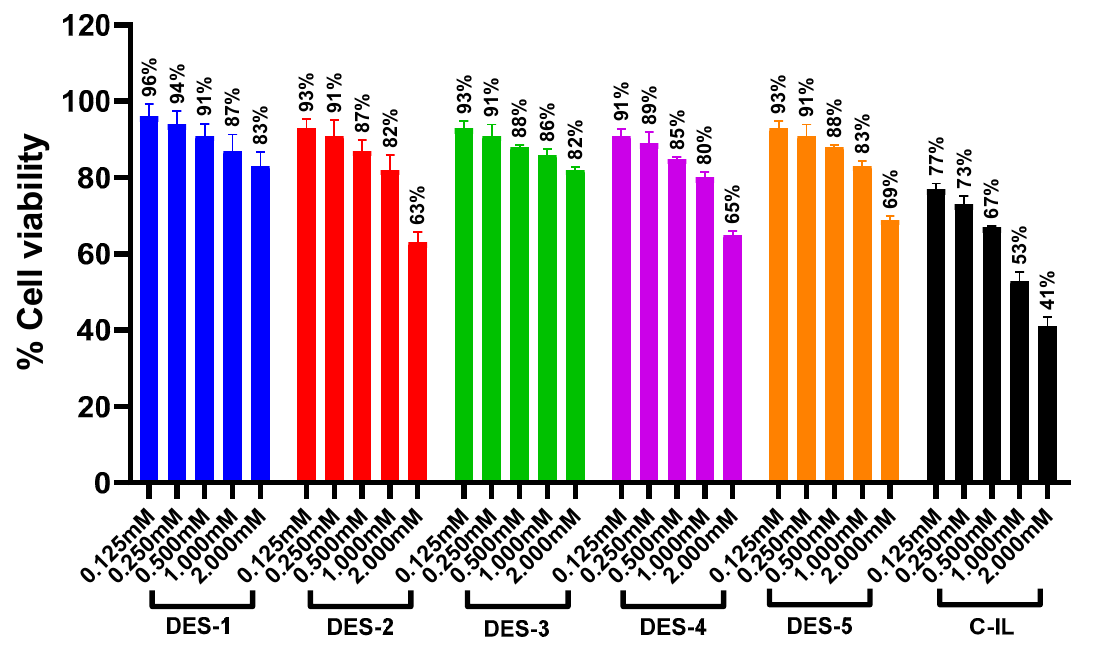
Figure 11. Effects of the five synthesized DESs on human cells at various concentrations. T = 25.0 ◦ C. Table 4. Methylene blue extraction efficiency comparison of synthesized DES with other DES- and IL-based extraction